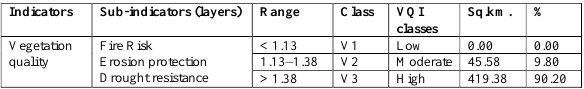
Fire risk Erosion protection Drought resistance Figure 5. Vegetation quality index factors